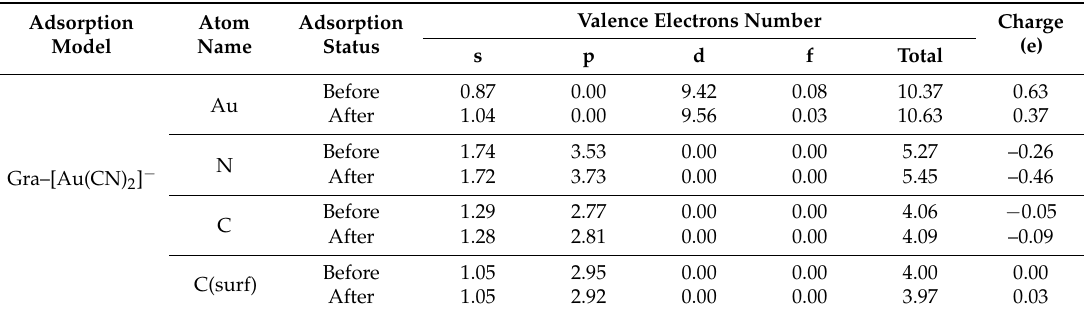
Table 3. Mulliken charge population of atoms before and after [Au(CN) 2 ] − adsorption to the graphite (0001)